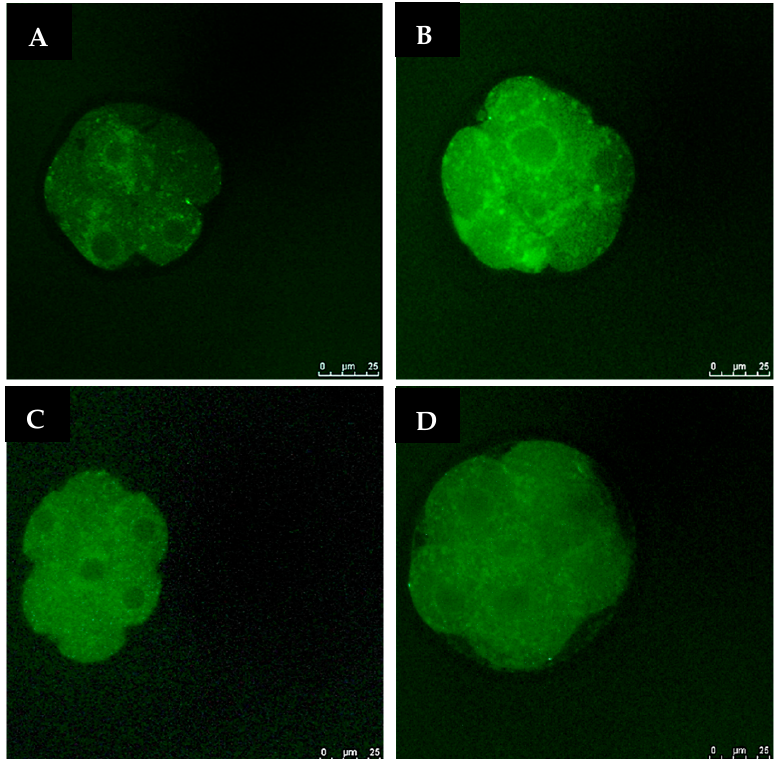
Figure 3. Fluorescent photomicrograph of embryos showing intracellular ROS contents. Images are viewed under 400 × magnification. ( A ): Group 1 (GSH-free medium); ( B ): Group 2 (GSH-free medium with vitrification); ( C ): Group 3 (0.01 mM GSH-supplemented medium), ( D ): Group 4 (0.01 mM GSH-supplemented medium with vitrification). The scale bar for the images represents 25 µ m.